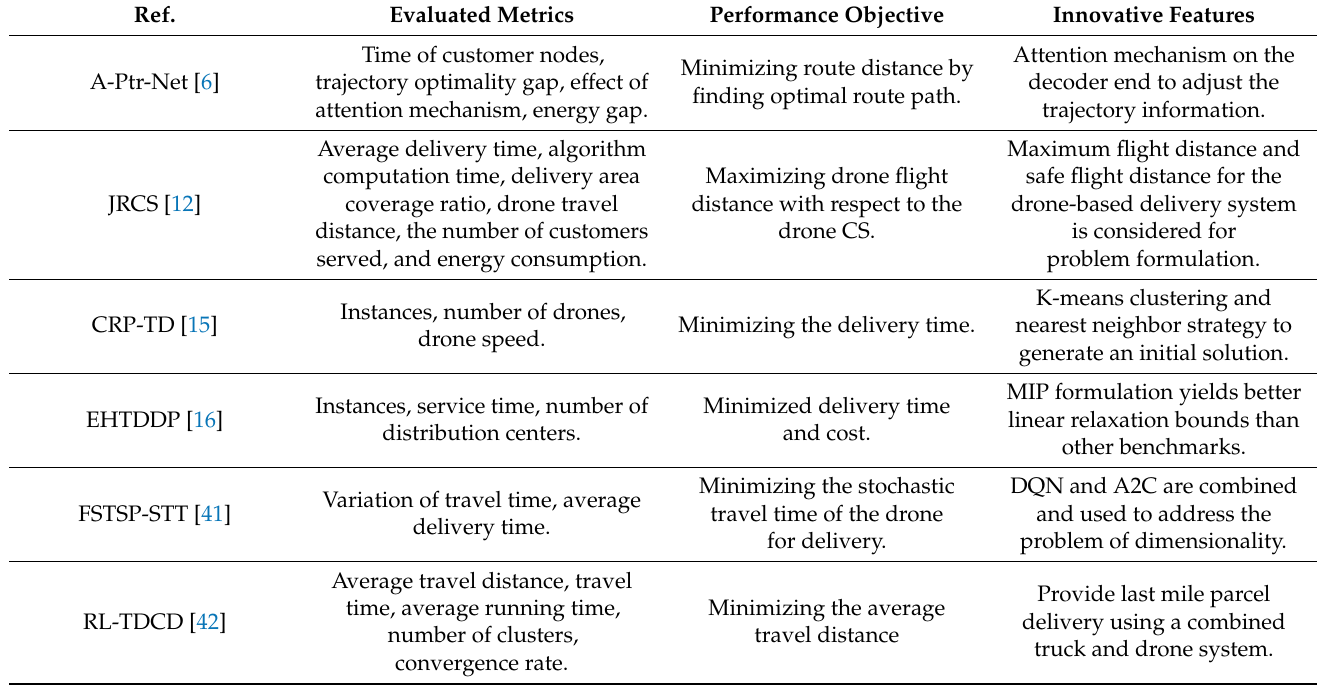
Table 3. Comparison of trajectory planning algorithms in drone routing in terms of evaluated metrices, performance objective, and innovative